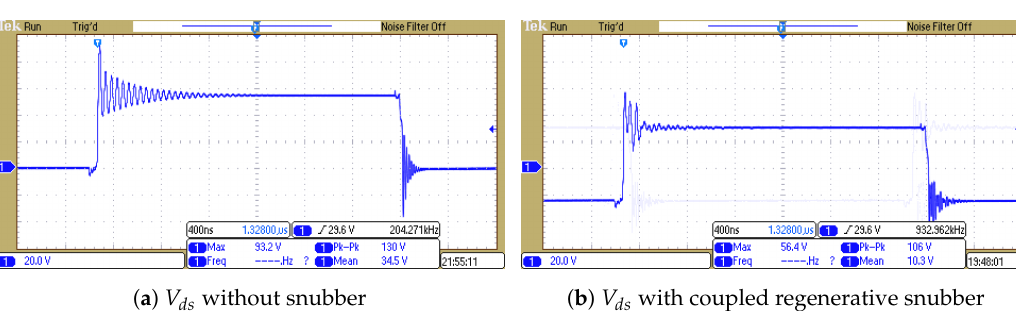
Figure 13. Experimental results for the voltage across the MOSFET switch “ V in = 24 V”.